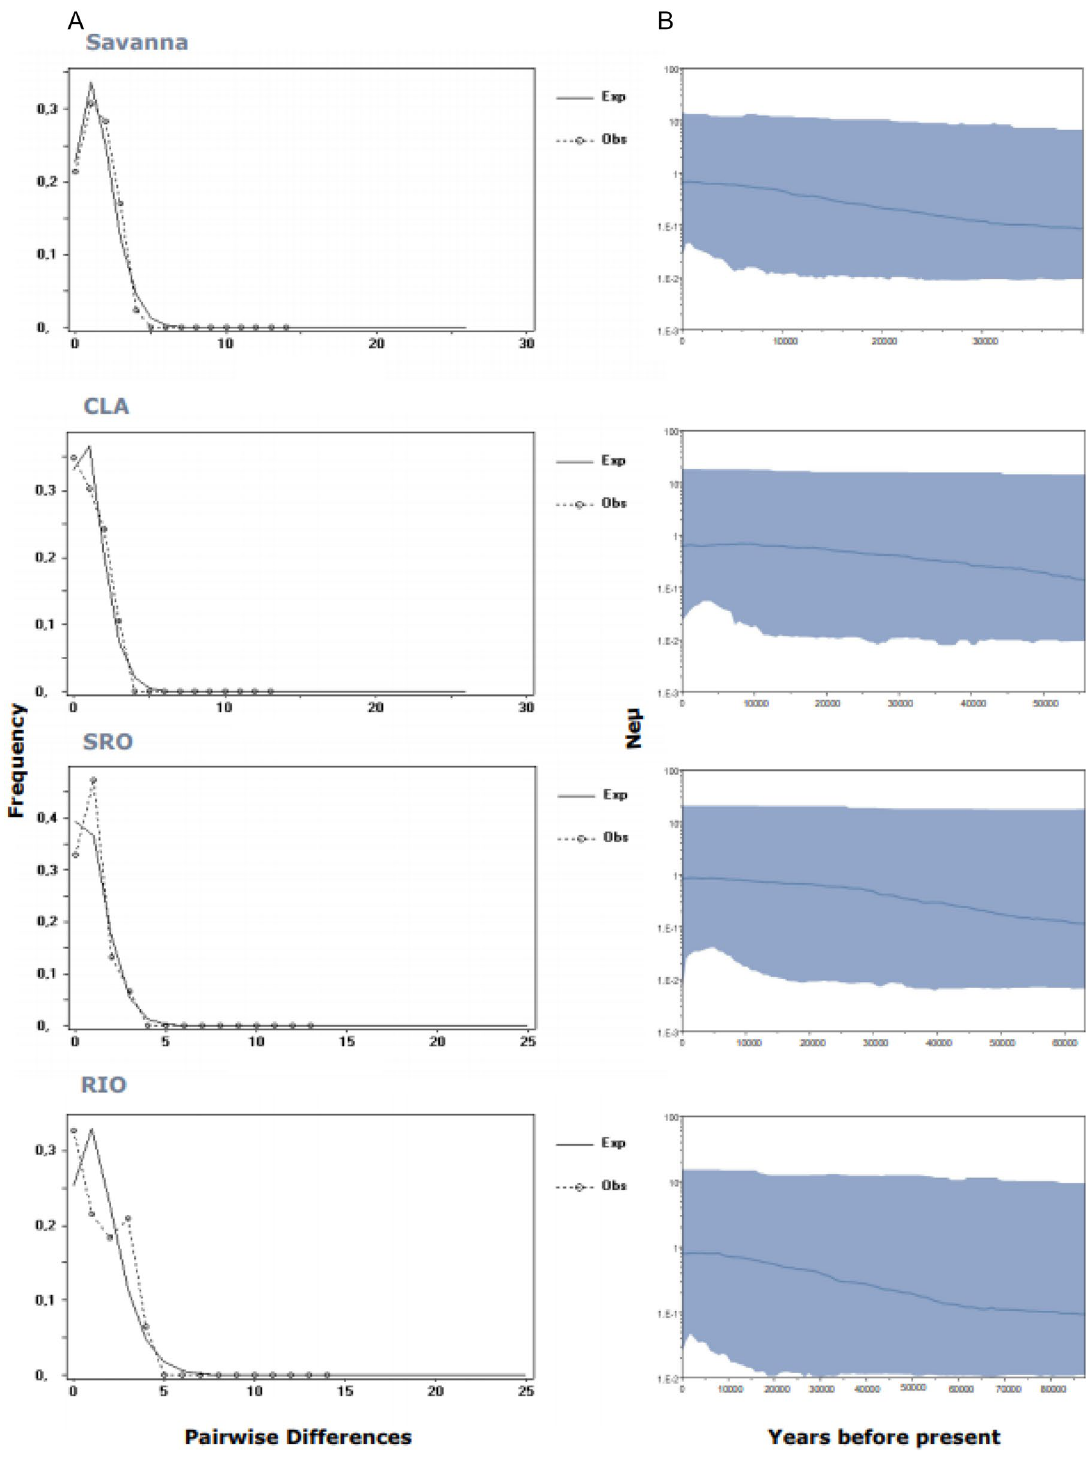
Figure 2. Mismatch distribution ( A ) and Bayesian skyline plots ( B ) of the Biome Savanna and the populations that showed significant raggedness index (r). For the mismatch distributions, solid lines show observed frequency distribution while dashes lines show the distribution expected under the sudden-expansion model. For the Skyline analysis, the x-axis represents time in units of years and the y-axis represents effective population size as Ne on a log scale. The blue line depicts the median population size, and the shaded areas represent the 95% highest posterior density